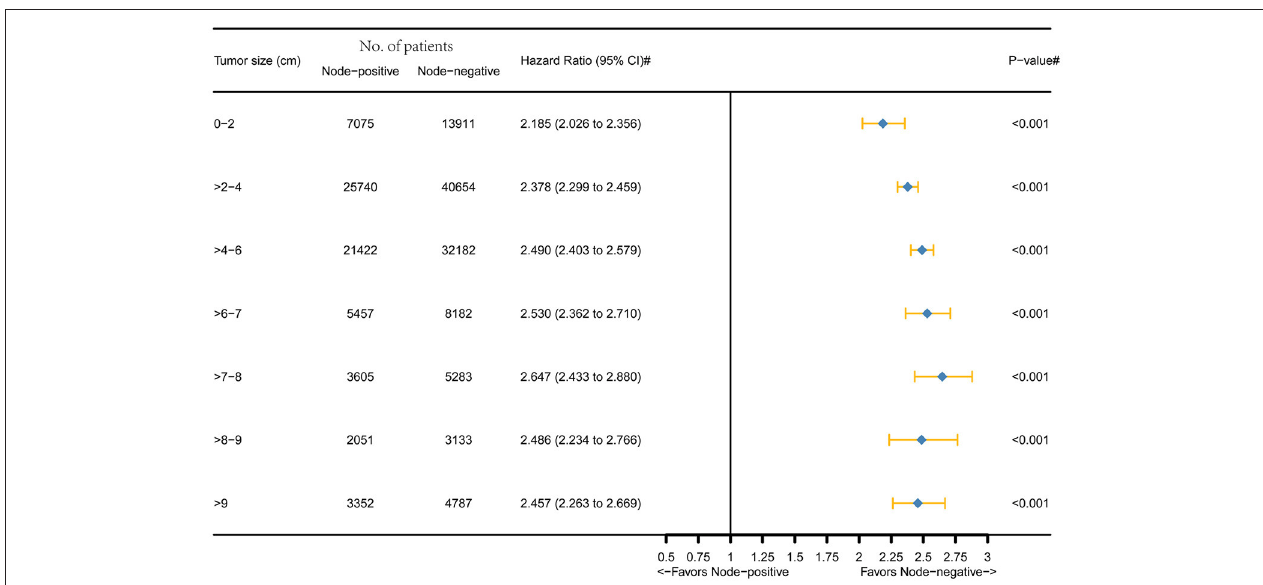
FIGURE 2 | Hazard ratio comparing node-positivity and node-negativity according to the tumor size on CSS. (#) Multivariate analysis adjusted by T stage, histology, tumor grade, race, gender, tumor location, age at diagnosis, and year of diagnosis.